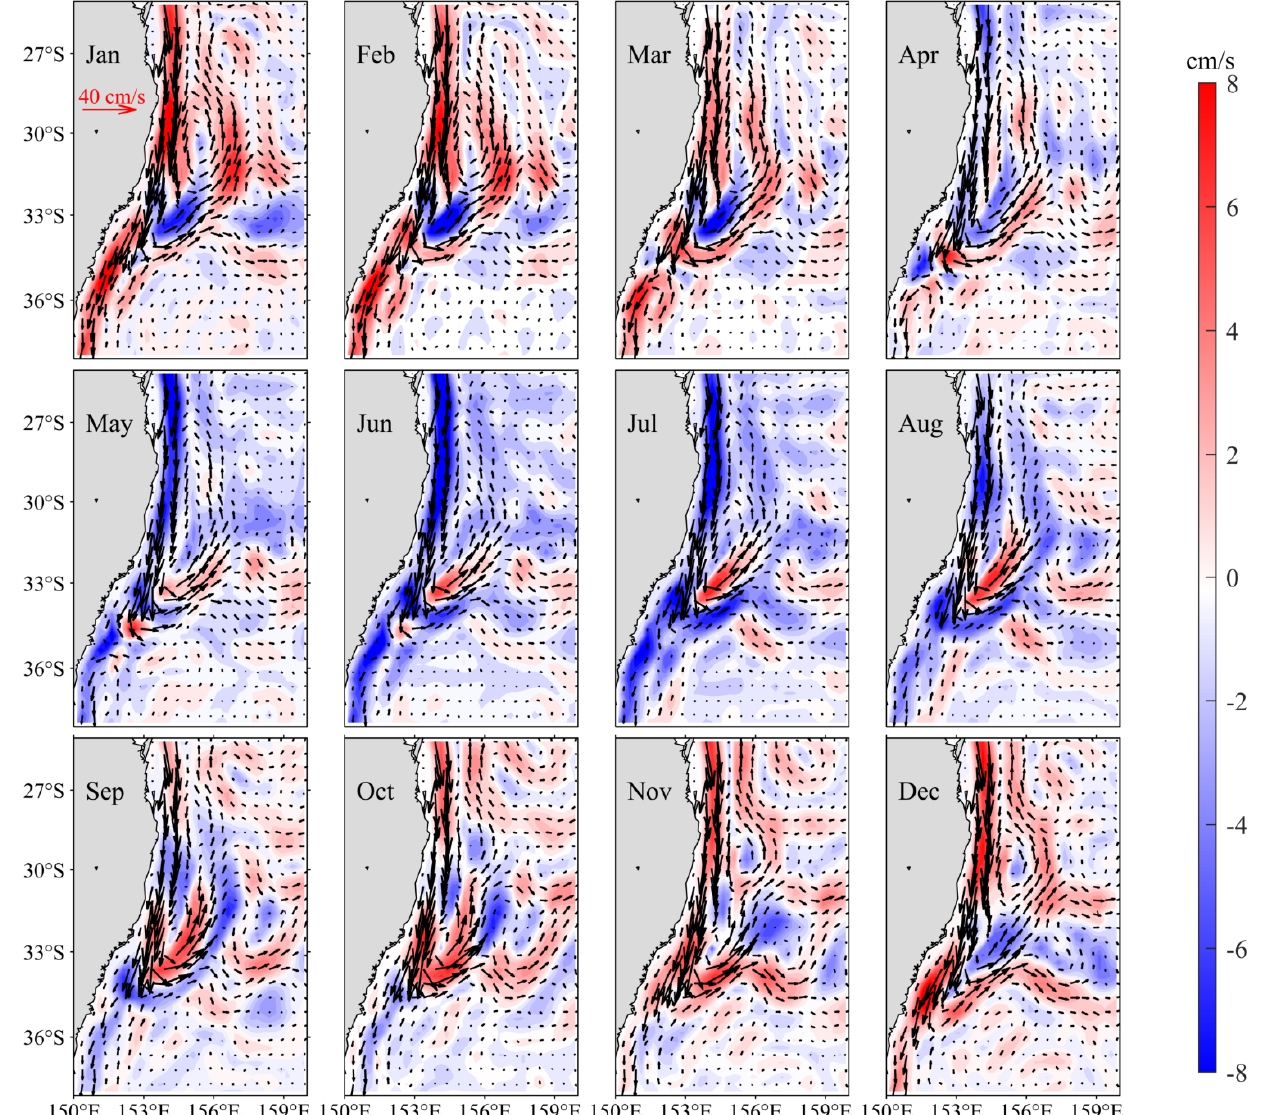
Figure 10. Monthly mean climatological background current distributions averaged in the upper 500 m layer, and color indicates velocity magnitude anomalies which have subtracted the annual mean value. Here velocities are based on the 180-day low - pass filtered ECCO2 outputs.